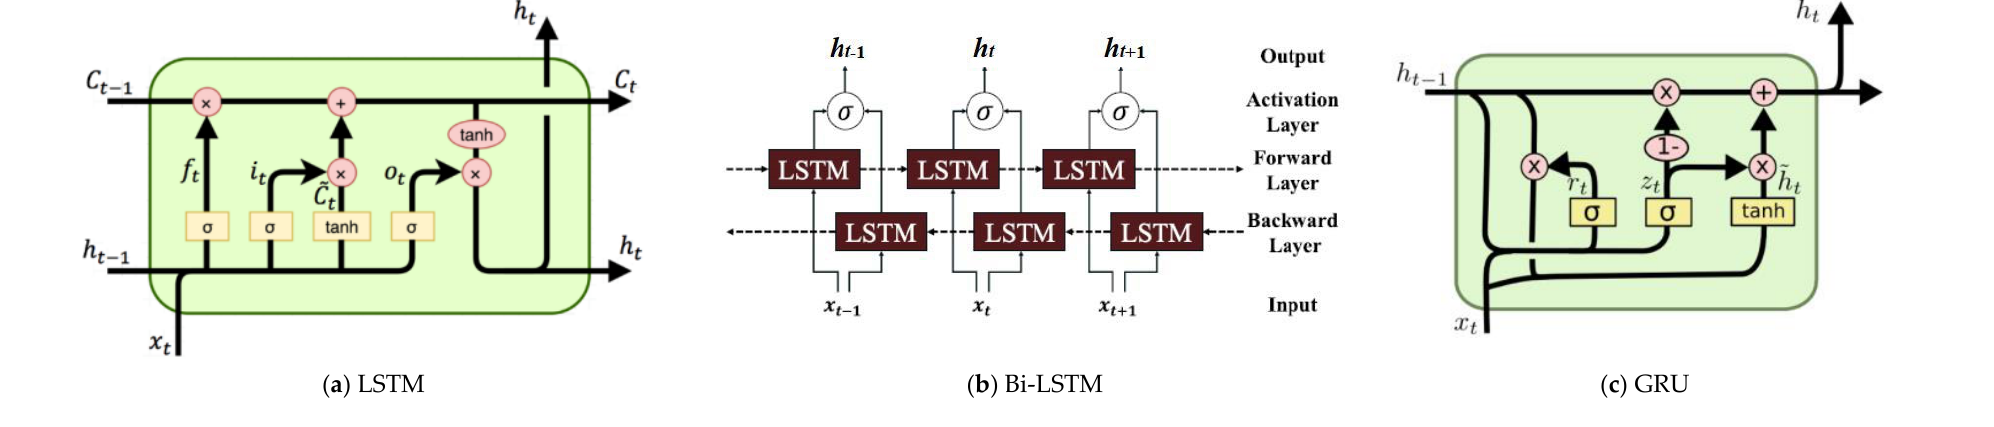
Figure 1. Structure of network according to Ko et al. [22], Graves [28] and Olah [29].